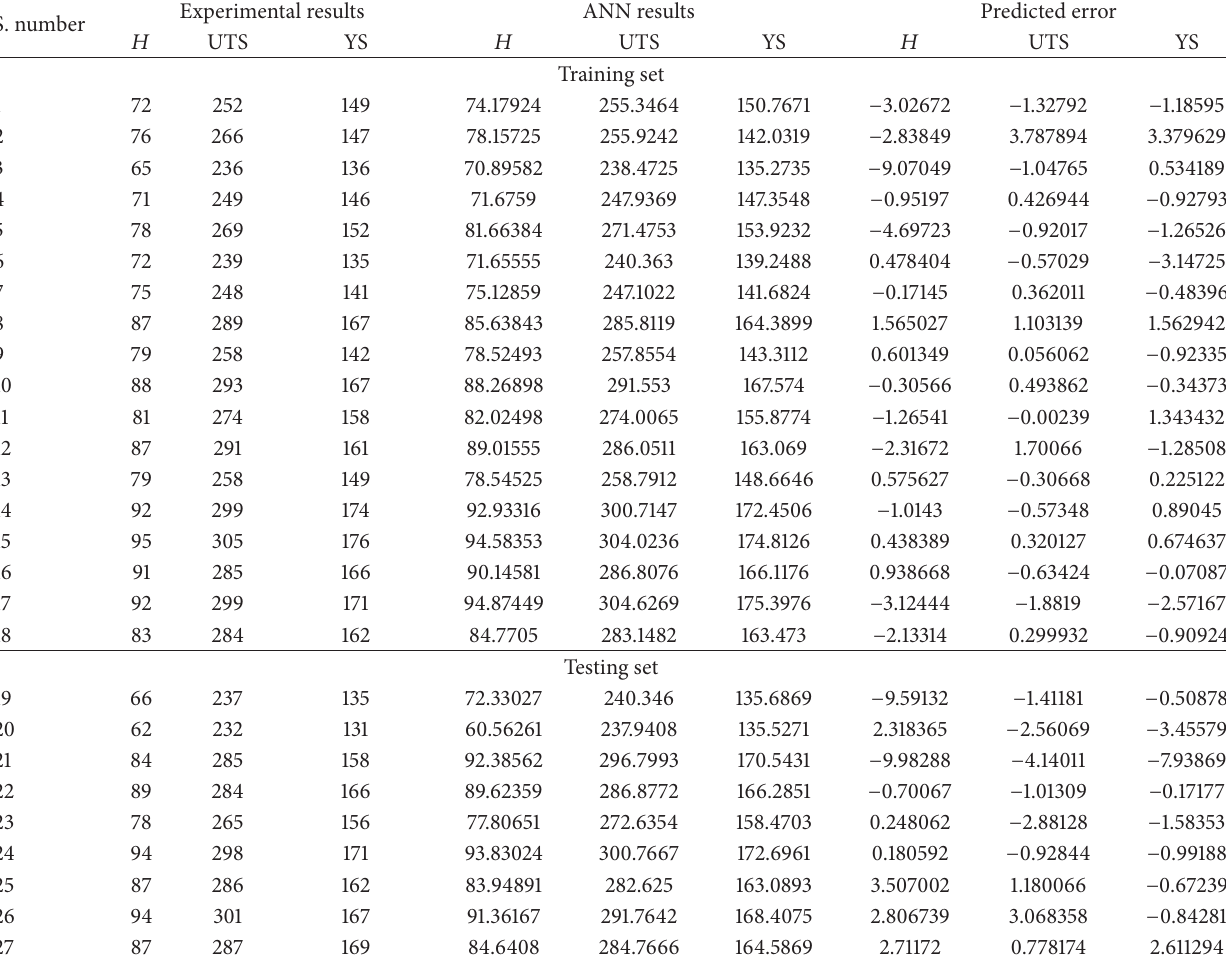
Table 6: Experimental and ANN results of training and testing data.